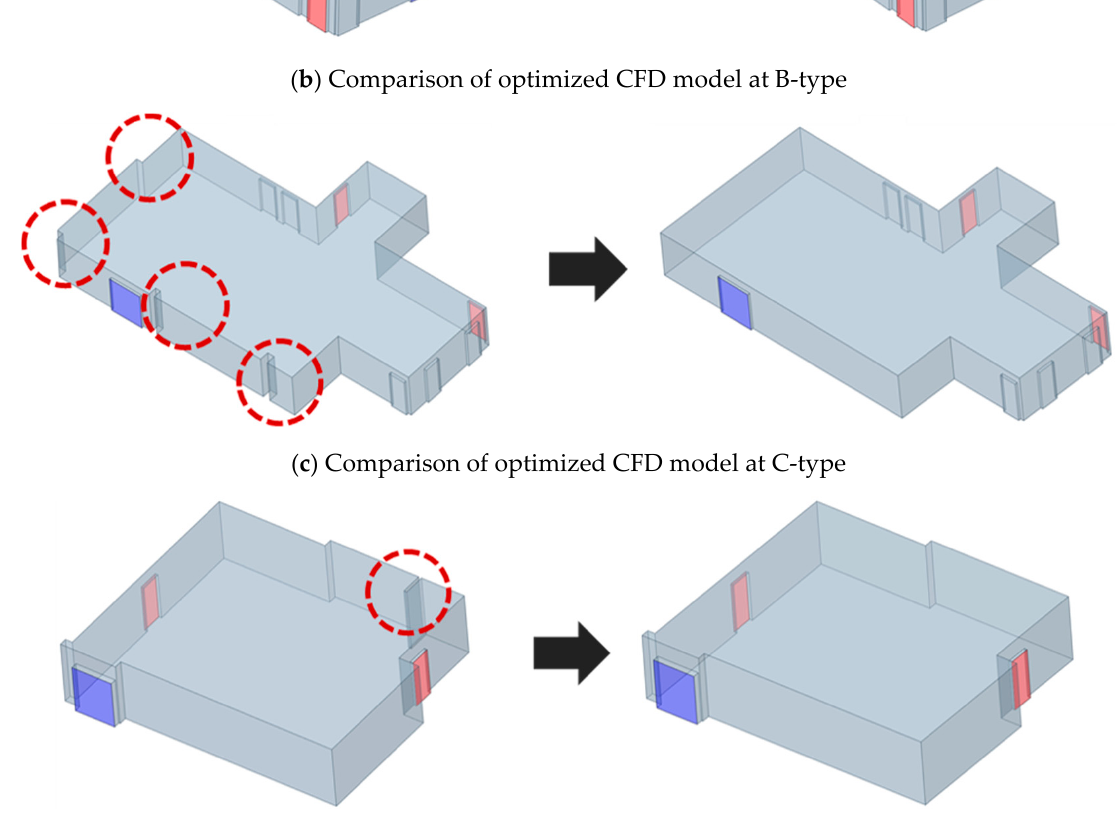
Figure 5. Geometry models according to optimization function.